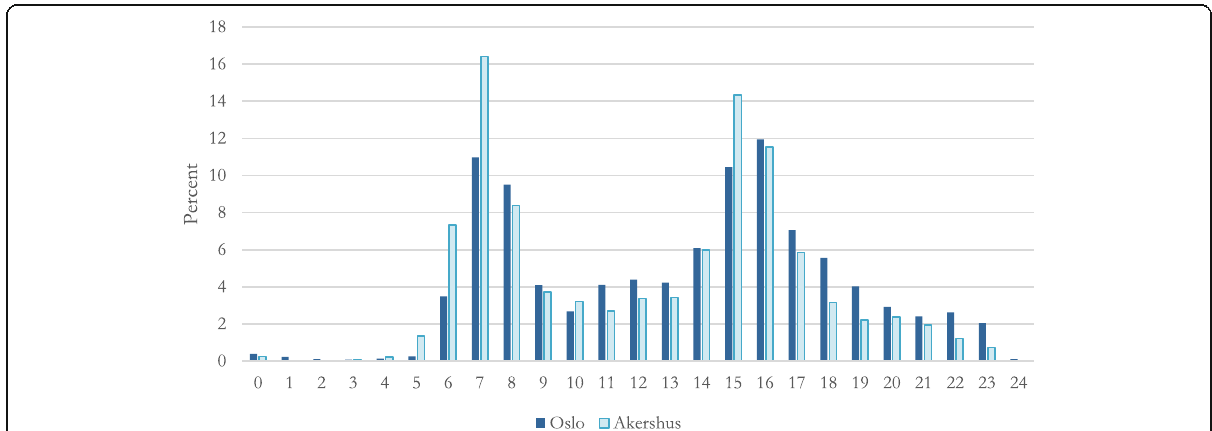
Fig. 2 Distribution of PT trips made by season ticket holders, by region and by hour of the day (Oslo city and its surrounding Akershus county) (NTS) (n= 5665,